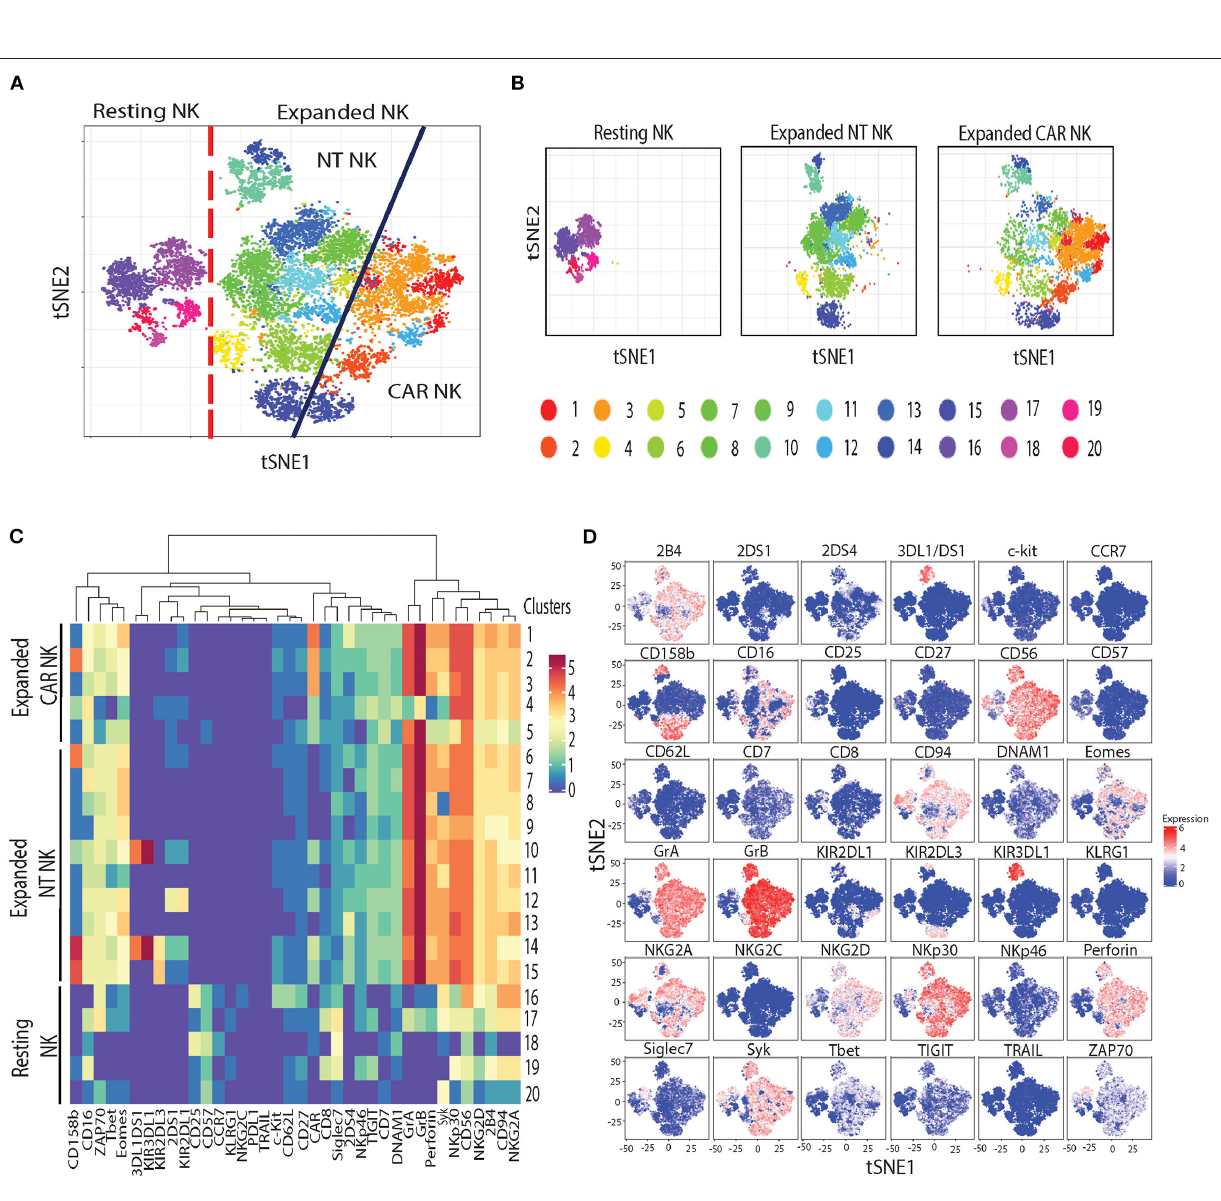
FIGURE 4 | cells (right) at day 0 (unstimulated; red) and day 15 after stimulation with uAPC (green). (B) Heatmaps displaying RNA sequencing data of differentially expressed genes in purified NT (left) or iC9/CAR.19/IL-15 (CAR, right) NK cells at baseline (Day 0) or Day 15 after co-culture with uAPC ( n = 3). Color scale reflects comparative RNA transcript levels, with red representing higher expression and blue representing lower expression. (C) Comparative Mean T Statistic bar graphs of RNA sequencing data showing the expression of pathways in NT (left) or iC9/CAR.19/IL-15 (CAR) NK cells (right) that are significantly increased (red) or significantly decreased (blue) upon stimulation with uAPC for 15 days. (D) Gene set enrichment analysis (GSEA) plots showing enrichment in E2F targets, glycolysis, oxidative phosphorylation and fatty acid metabolism in uAPC-activated NT NK cells (top plots) and iC9/CAR19/IL-15 (CAR) NK cells (bottom plots).